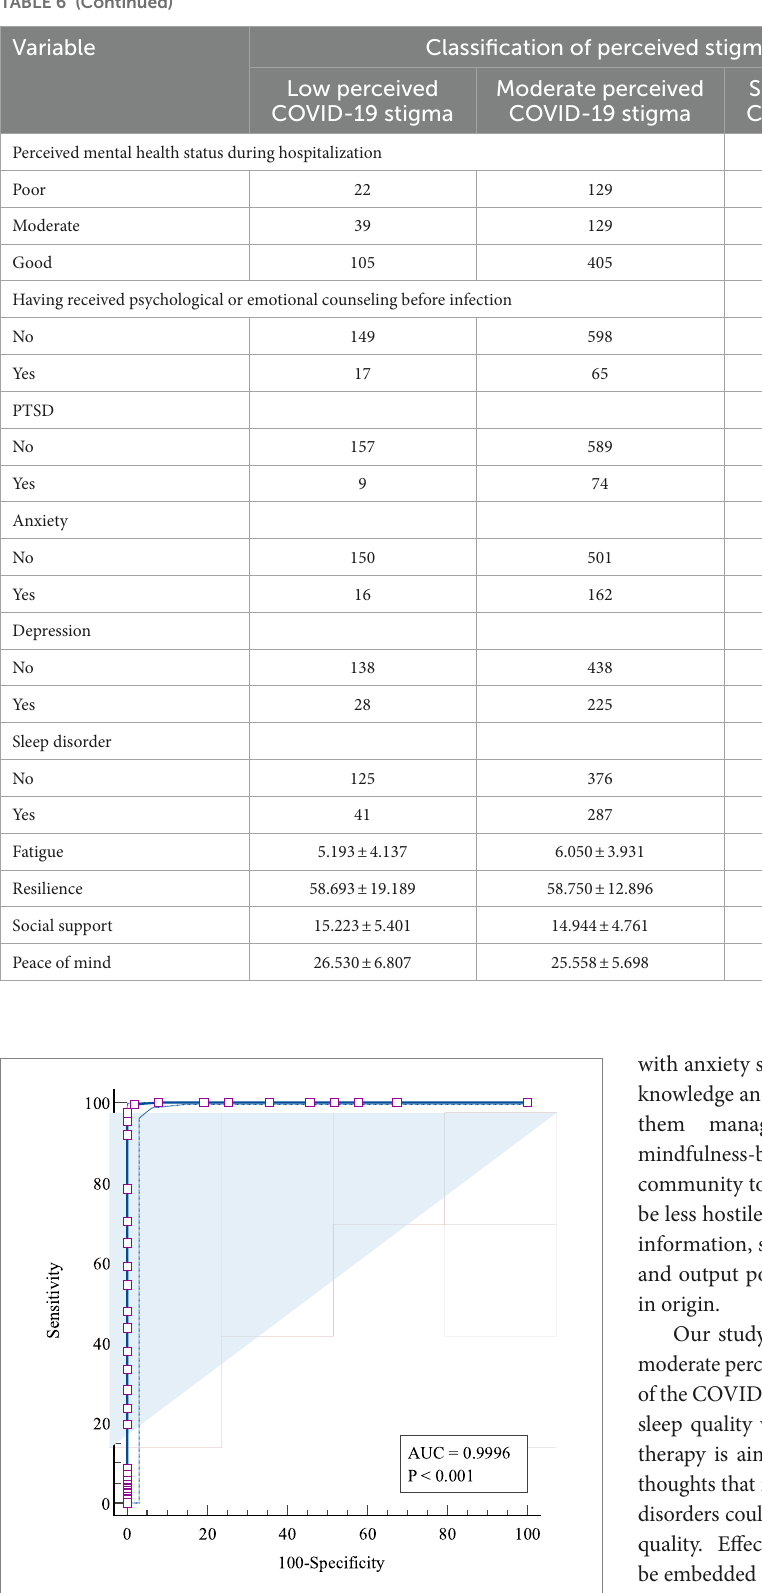
FIGURE 3 The receiver operating characteristic (ROC) curve of the CSS-S for screening perceived COVID-19